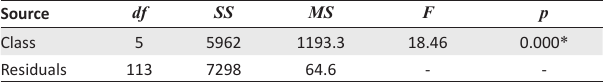
TABLE 7b: Regression coefficients. † Model